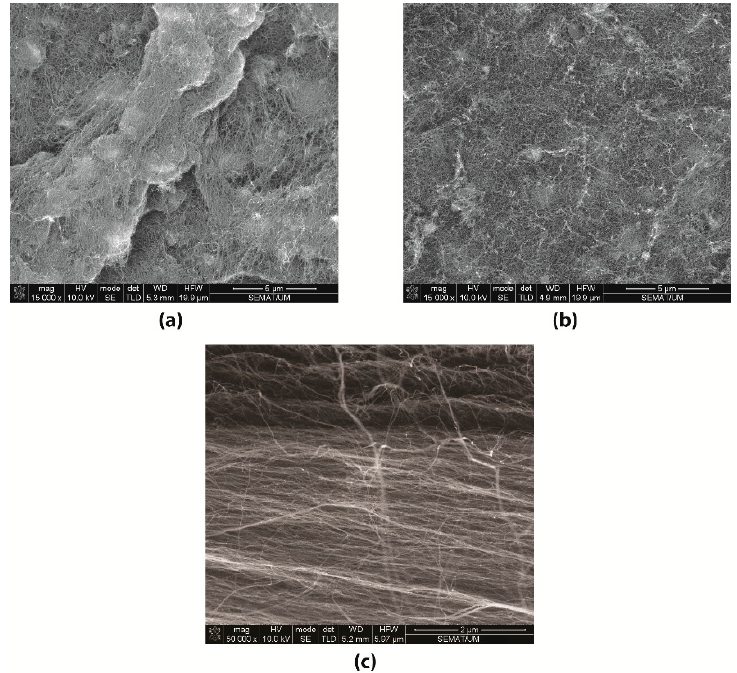
Figure 2. SEM images of the BP DMF ( a ), BP ETOH ( b ), and knocked-down carbon nanotubes (CNTs) ( c ) samples.